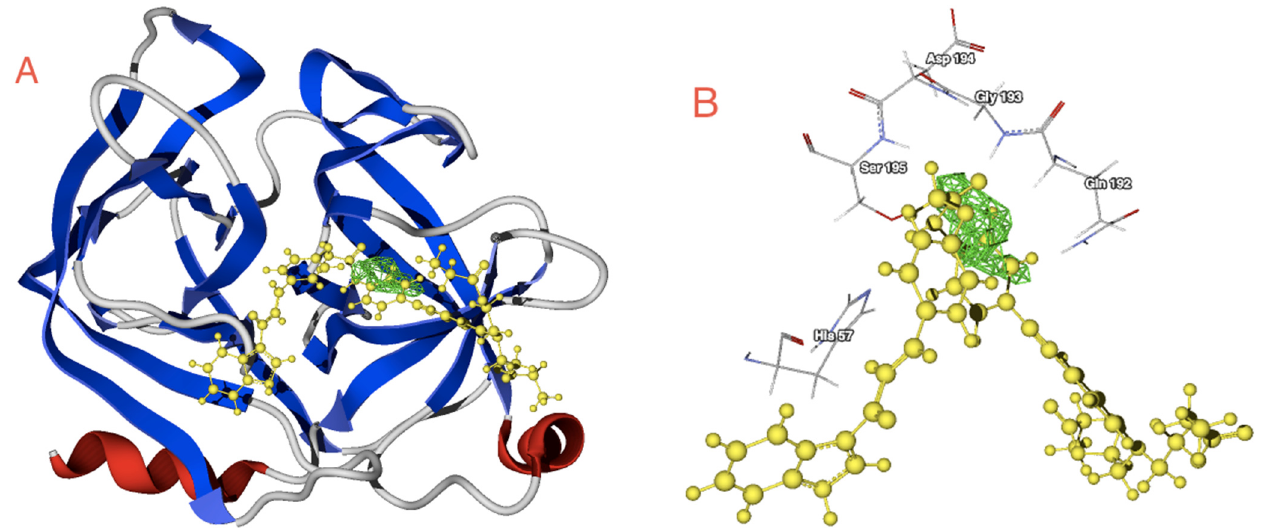
Figure 8. ( A ) Molecular docking between the KLK5 protease and the synthesized ligand 15 . ( B ) Main locations of KLK5 protease interacting with 15 .